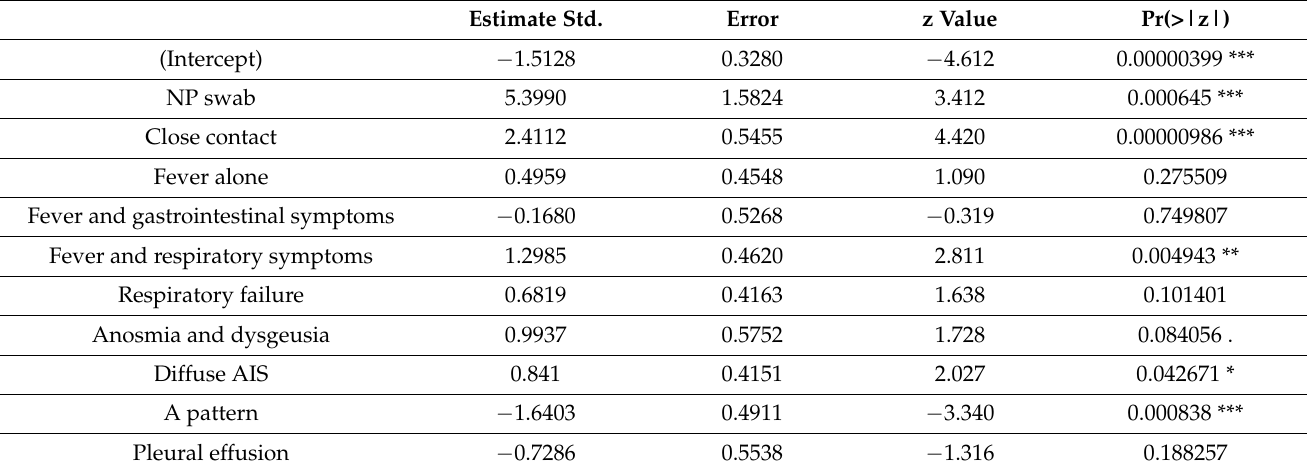
Table 4. Results from the logistic regression analysis: coefficients on the log-odd scale and associ- ated standard errors, significance tests. NP, nasopharyngeal. AIS, alveolar-interstitial